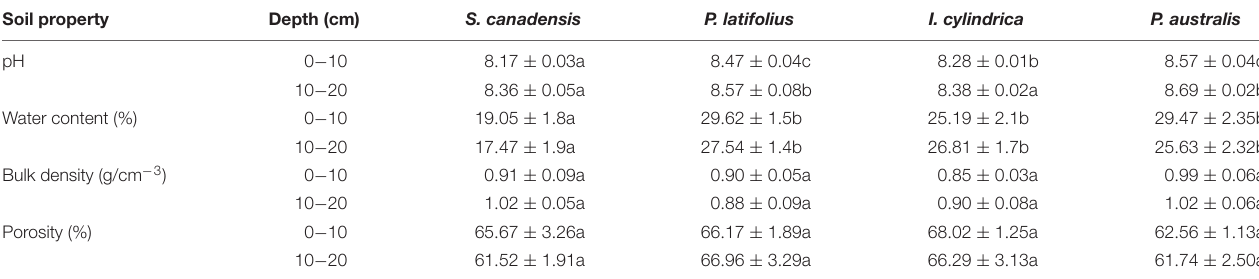
TABLE 2 | Basic properties at the two soil depths in the community dominated by each of the four plant species. Soil property Depth (cm) S.